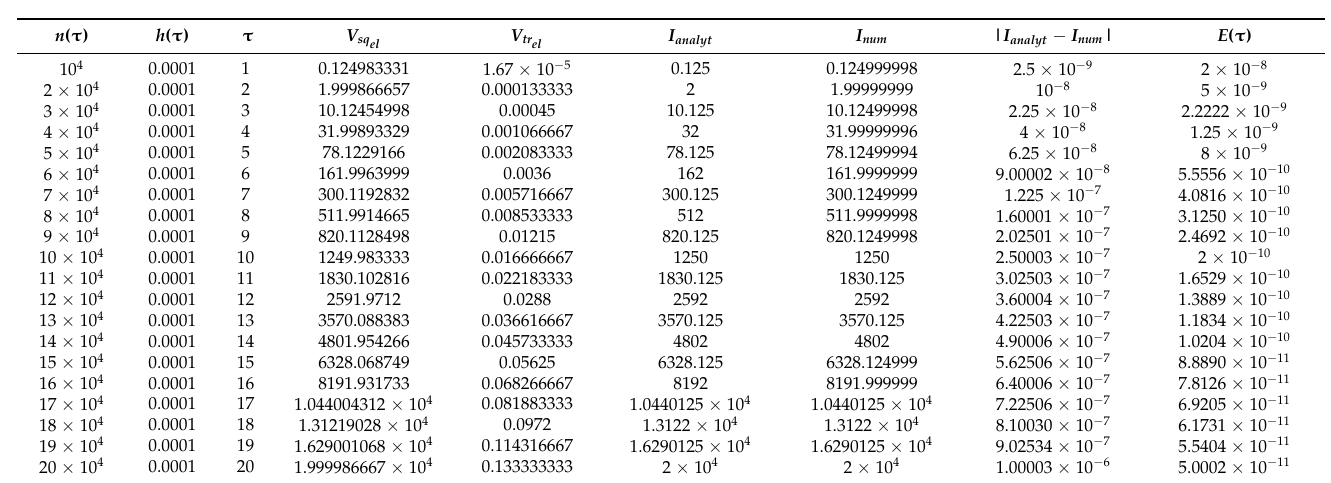
Table 2. Calculation of integral